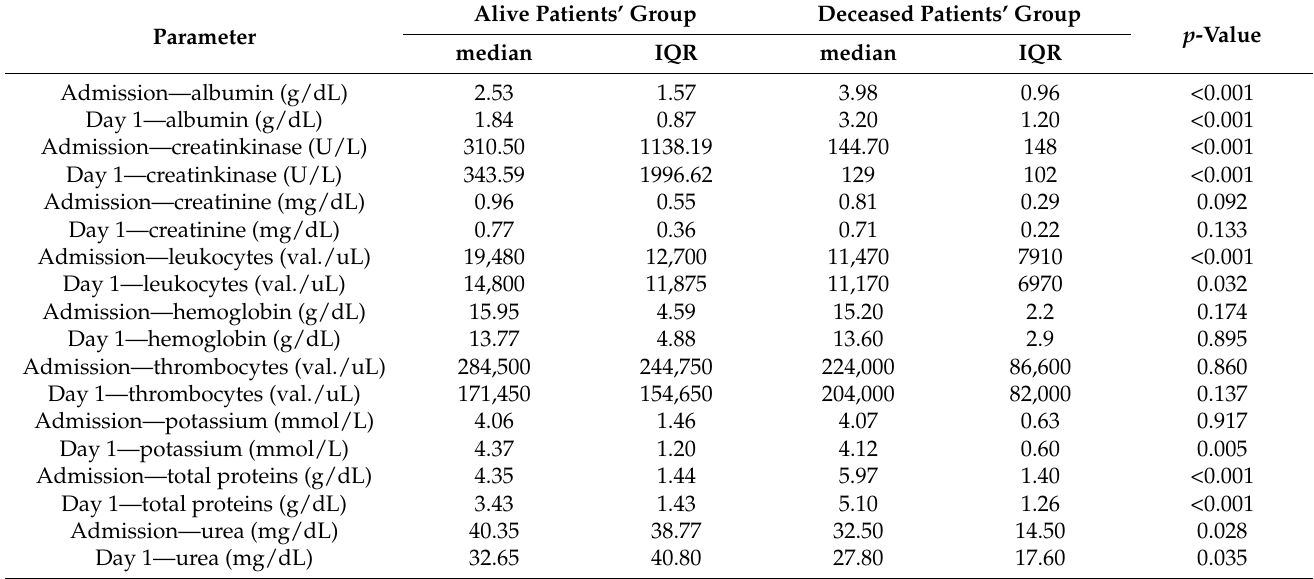
Table 3. Comparative analysis of laboratory parameters between the studied groups.